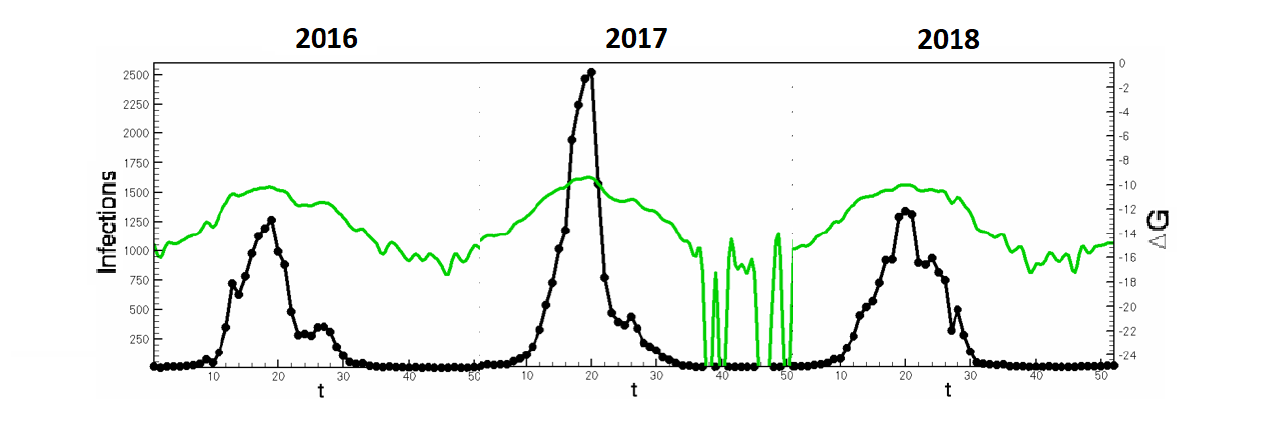
Figure 7. Infection counts shown on the primary y -axis by the black line, and ¯ ∆ G I shown on the secondary y -axis by the green